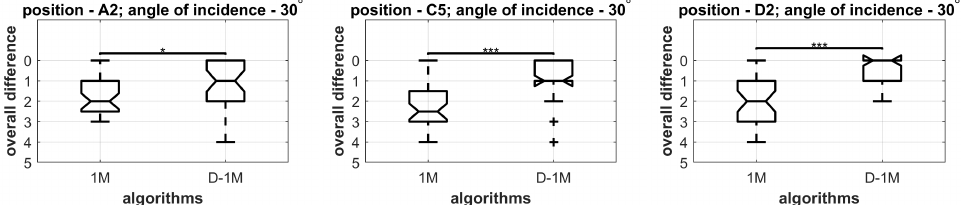
Figure 17. Perceived overall difference between the synthesized BRIRs and the measured BRIRs for two synthesis methods, without (1M) and with (D-1M) inclusion of the SSD, and for the synthesized positions “A2”, “C5”, and “D2” for an incidence angle of 30 ◦ . A value of “0” indicates no perceptual difference and “5” a very high difference.—*** p ≤ 0.001, * p ≤ 0.05 (Wilcoxon signed rank